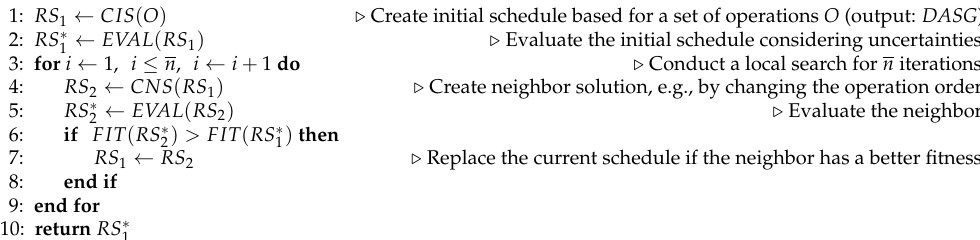
Algorithm 1 Exemplary local search robust scheduling heuristic (simplified